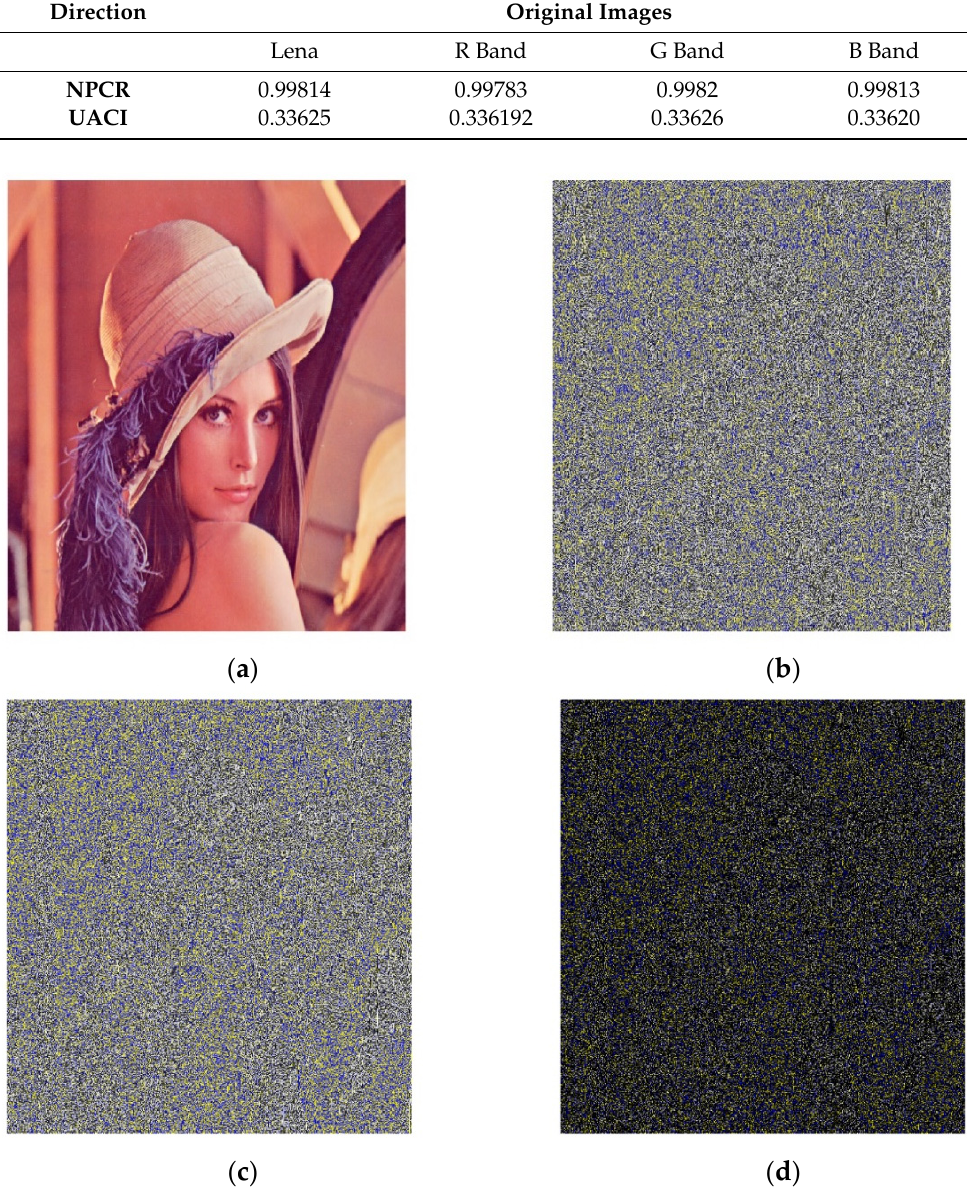
Figure 17. Sensitivity of key test: ( a ) original image, ( b ) encrypted image, ( c ) recovered image with variation (10 − 15 is added to q ) of the decryption keys, ( d ) difference between ( a , c ).